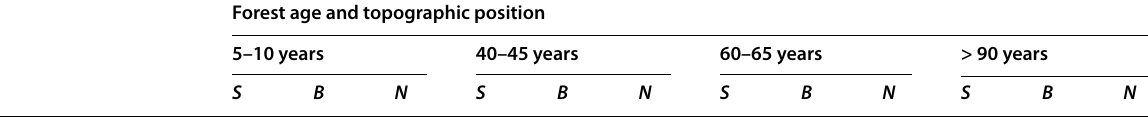
Table 3 List of diagnostic species for topographic positions (S: south-facing slope, B: bottom, and N: N-facing slope) in the forest age classes (class 1: 5–10-year-old forest stands with mature forest patches, class 2: 40–45-year-old forests, class 3: 60–65-year-old forests, and class 4: more than 90-year-old forests) in dolines. Within blocks, species are listed by decreasing values of the phi (Φ) coefficient. Fidelity values (Φ 100) of beech forest species, oak forest species, and species of disturbed forests are indicated with superscripts b, × o, and d, respectively. Non-diagnostic species were excluded with Fisher’s exact test ( p <